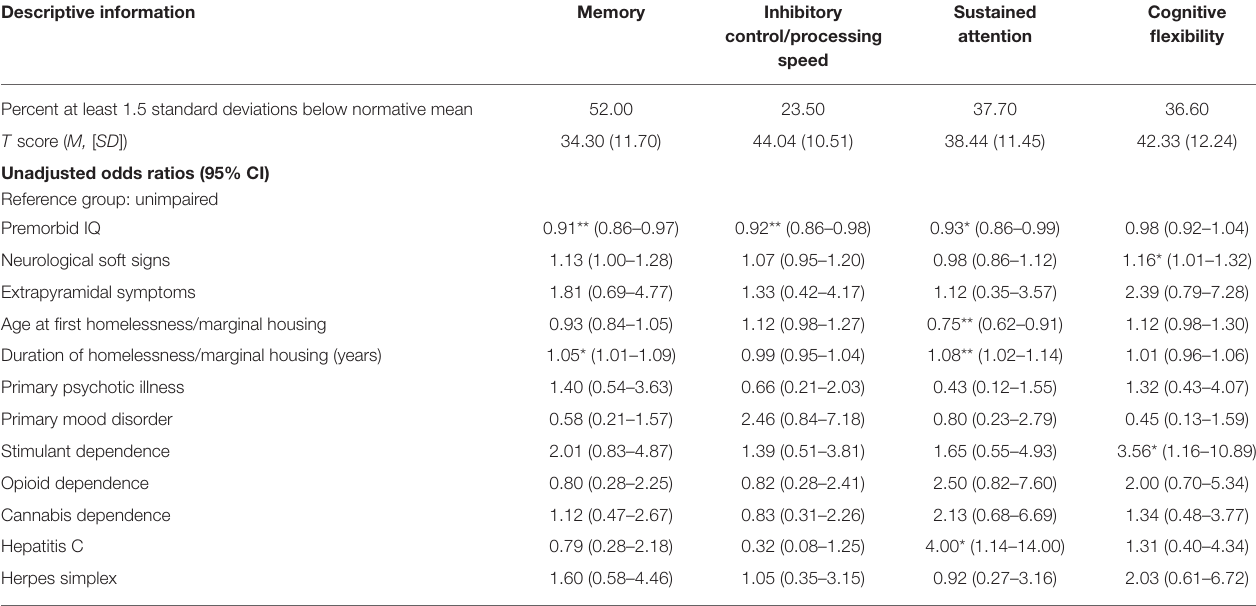
TABLE 1 | Associations between cognitive impairment and developmental and health risk